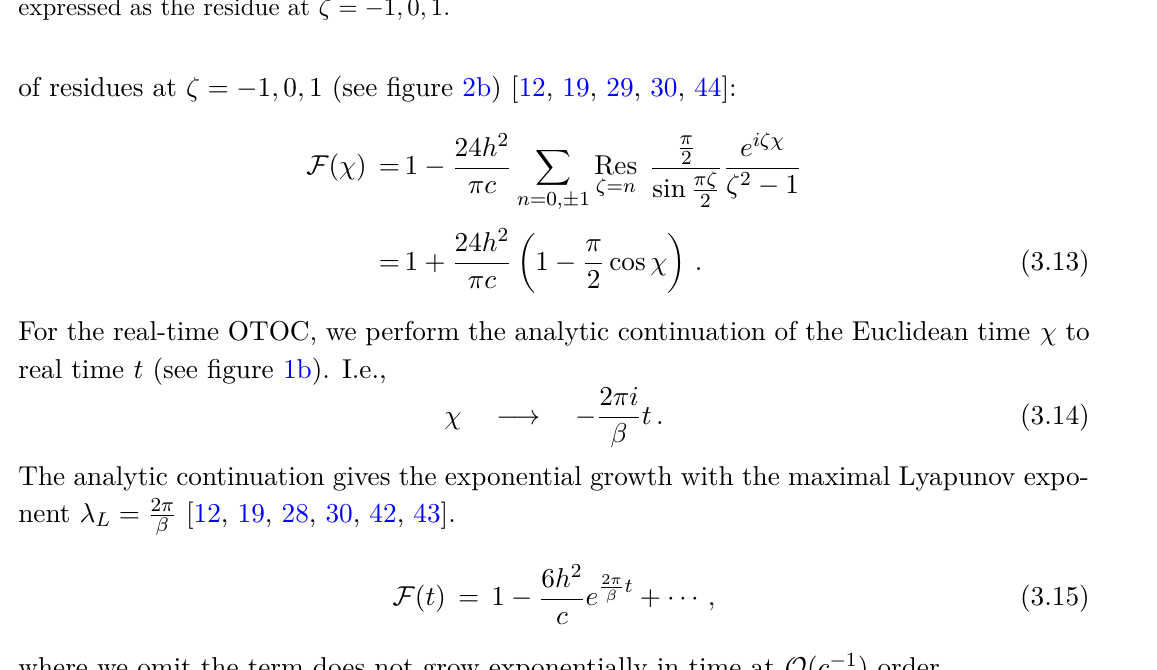
Figure 2 . The soft mode contribution can be written as a contour integral along a collection of small counterclockwise circles centered at ζ ∈ Z / {− 1 , 0 , 1 } . By deforming the contour, it can be expressed as the residue at ζ = − 1 , 0 , 1